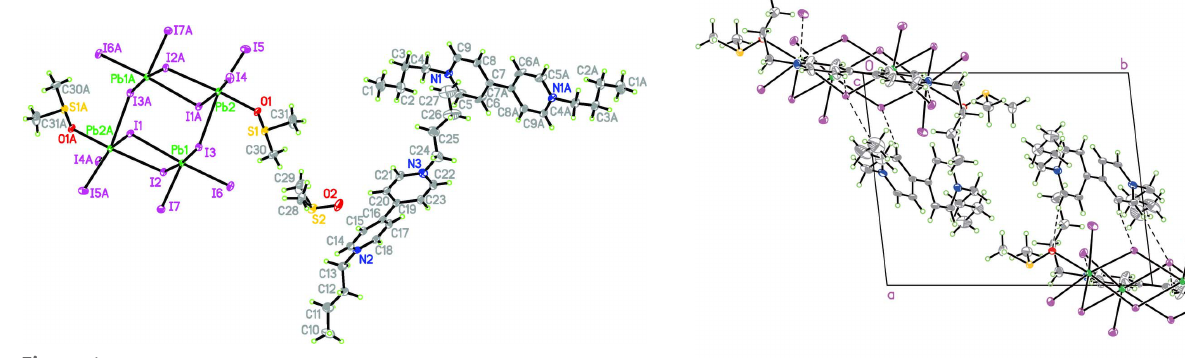
Figure 1 The molecular structure of the title compound. Displacement ellipsoids are drawn at the 25% probability level. The second lattice DMSO molecule and the third VB cation, generated by symmetry, are omitted for clarity. Symmetry code: (A) (cid:3) x , (cid:3) y , (cid:3) z